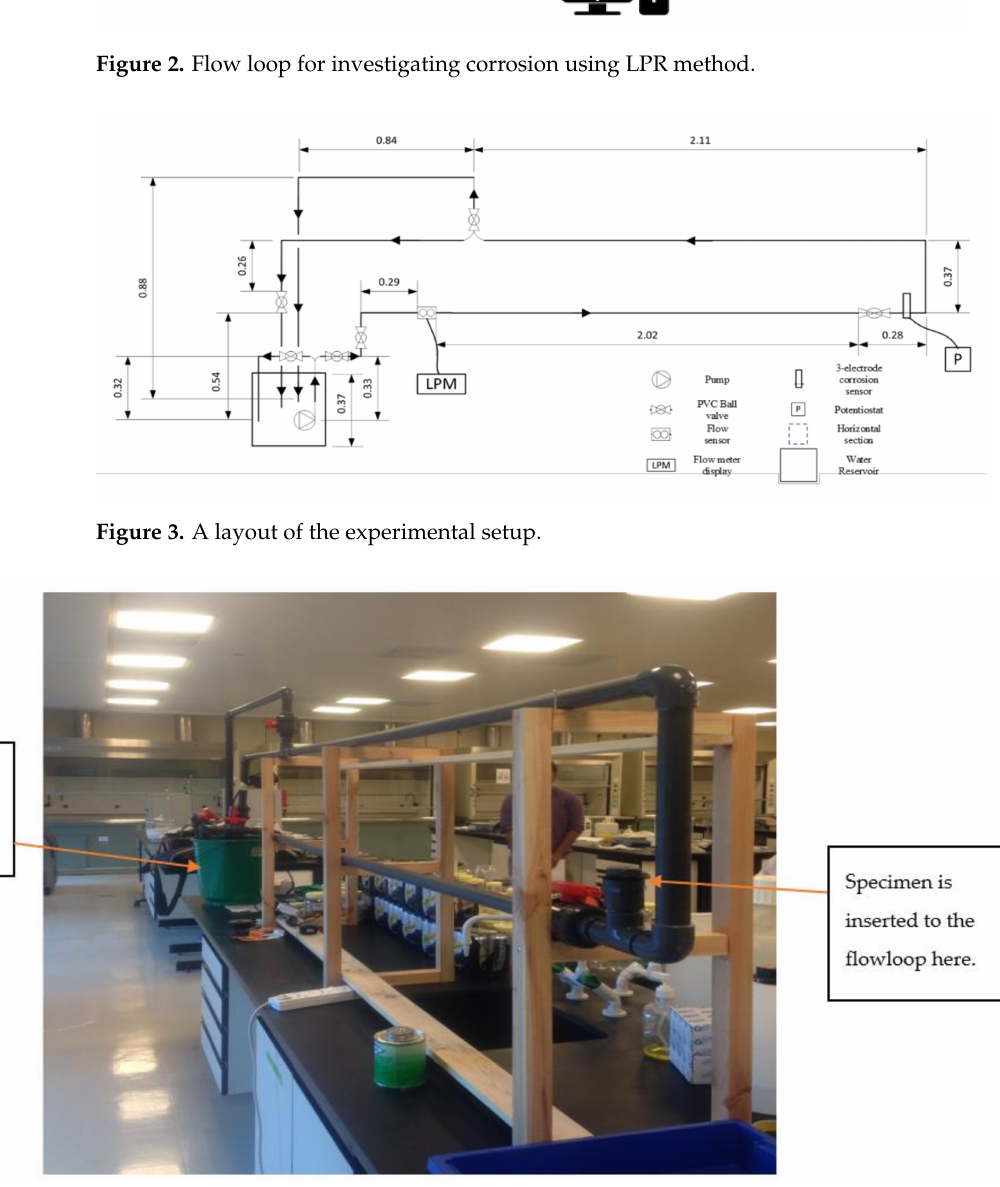
Figure 4. The actual flow